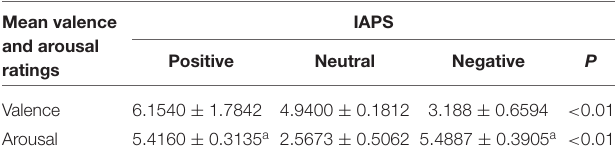
TABLE 1 | Means and standard deviations for arousal and valence for each IAPS.